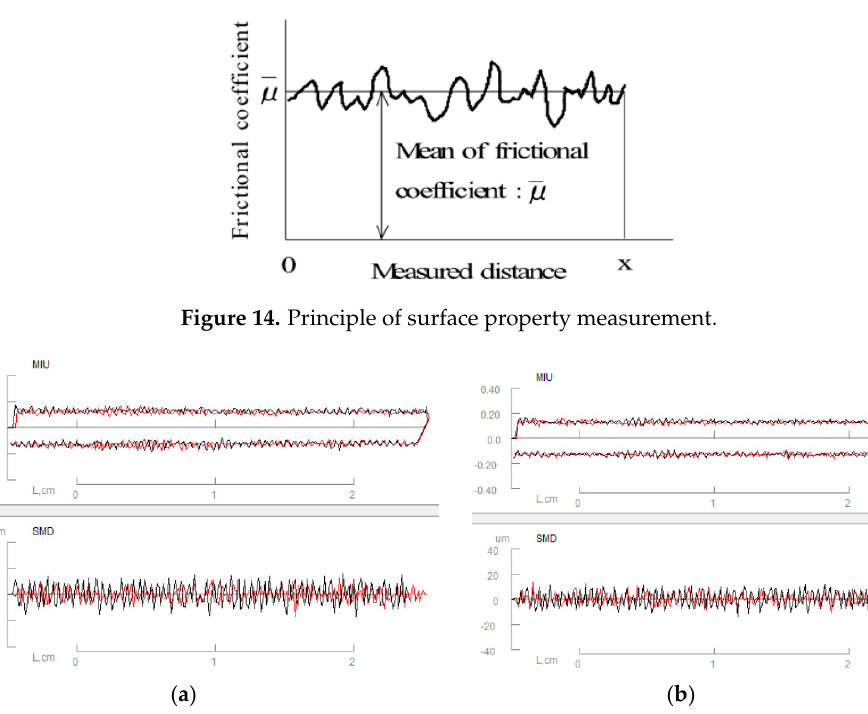
Figure 15. Surface property of ( a ) woollen fabric; ( b ) woollen fabric with interlining.